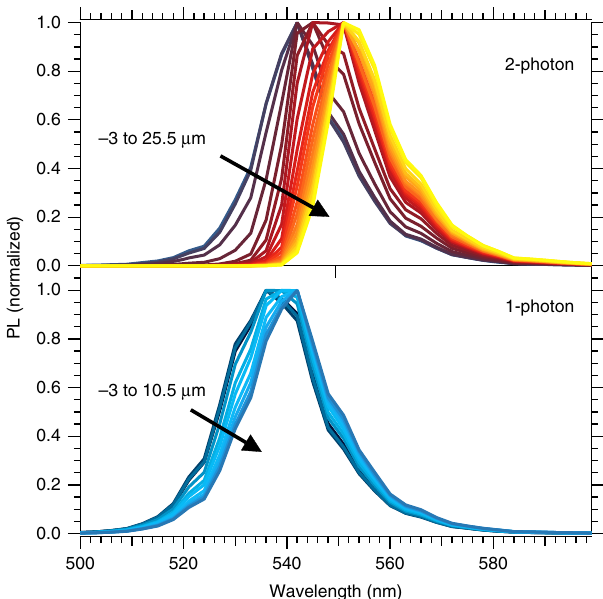
Fig. 3 Photoluminescence (PL) spectra with 1-photon (1P) and 2-photon (2P) excitation. ( top ) Normalized PL spectra for 2P excitation ( λ exc = 800 nm) where the focal depth is varied from − 3 (above the surface) to 25.5 µ m. ( bottom ) Normalized PL spectra for 1P excitation ( λ exc = 488 nm) where the focal depth is varied from − 3 (above the surface) to 10.5 µ